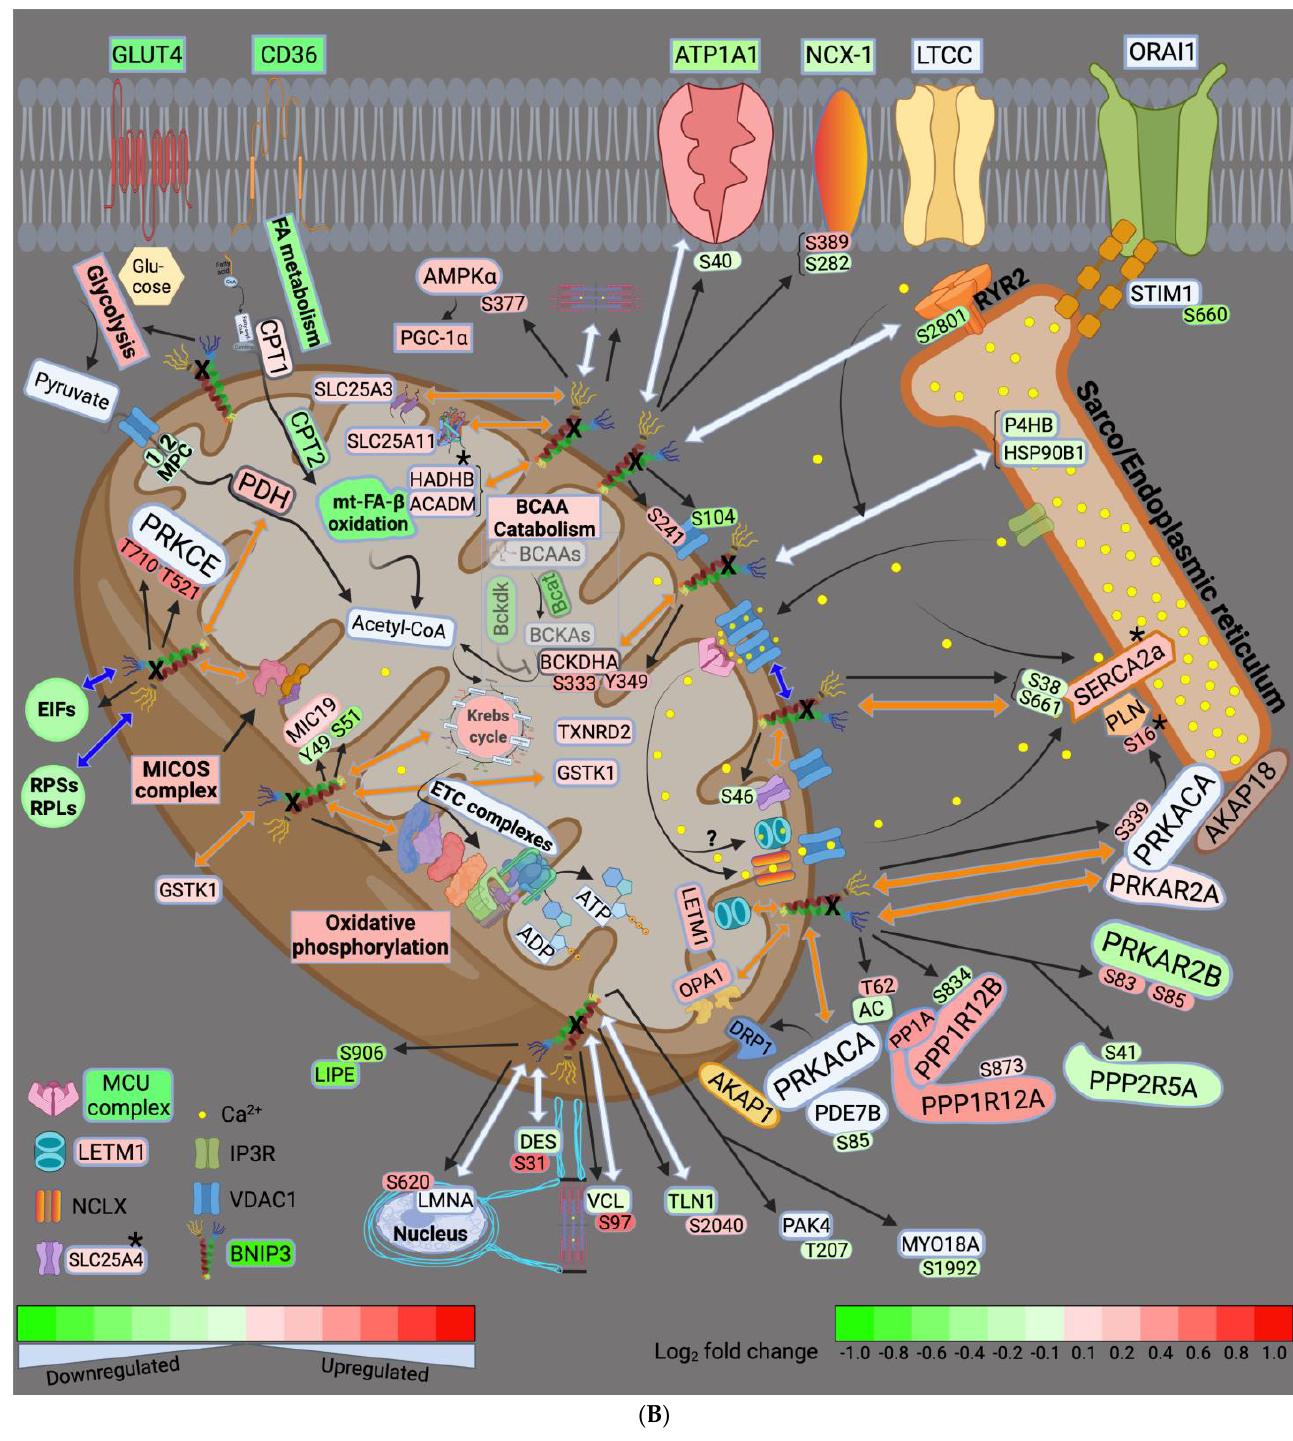
Figure 8. Schematic drawings highlight some of the key findings of the effect of BNIP3 knockdown in the rat pressure overload HFrEF model. These are presented as ShL vs. Sham ( A ) and ShB vs. ShL ( B ). The green and red color intensities show the degree of downregulation and upregulation of activity, respectively, or the log 2 -fold change in protein or phosphosite expression, as noted by the scale bar at the bottom right side of the schematic drawing. The double-headed arrows show the interaction between BNIP3 and its interacting protein. The blue and orange colors show whether there was inhibition/downregulation or activation/upregulation as a result of this interaction. The straight black arrows point to an effect of BNIP3 on protein phosphorylation. The black asterisk denotes changes in protein expression or phosphorylation by western blot only. Abbrevi-